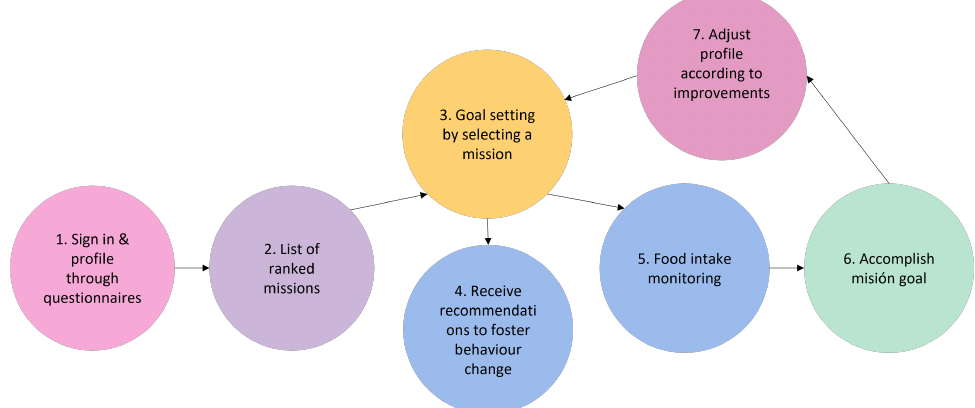
Figure 2. Workflow of CarpeDiem app’s nutrition pillar.